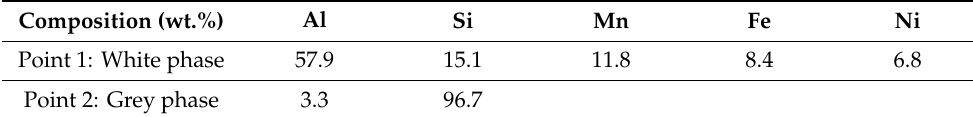
Figure 1. Typical SEM images showing the microstructures of Al-11.5Si-1.0Mg-0.5Cu-0.5Ni base alloy and Si 3 N 4 w / Al-11.5Si-1.0Mg-0.5Cu-0.5Ni composite: ( a ) SE image of the base alloy; ( b ) SE image of the composite; ( c ) secondary electron (SE) image and ( d ) backscattered electron (BSE) image of the composite at a lower magnification for an overall view. Table 1. Results of EDS analyses of Si 3 N 4 w / Al-11.5Si-1.0Mg-0.5Cu-0.5Ni composite in Figure 1d.